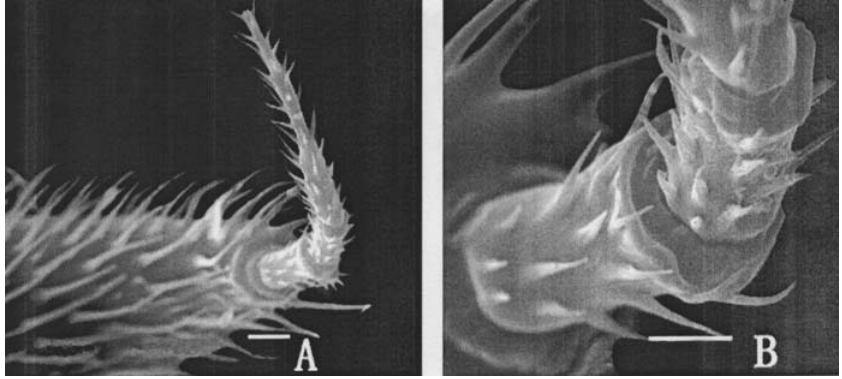
Fig.5. SEM micrographs of antennal arista of female decapitating phorid fly P.